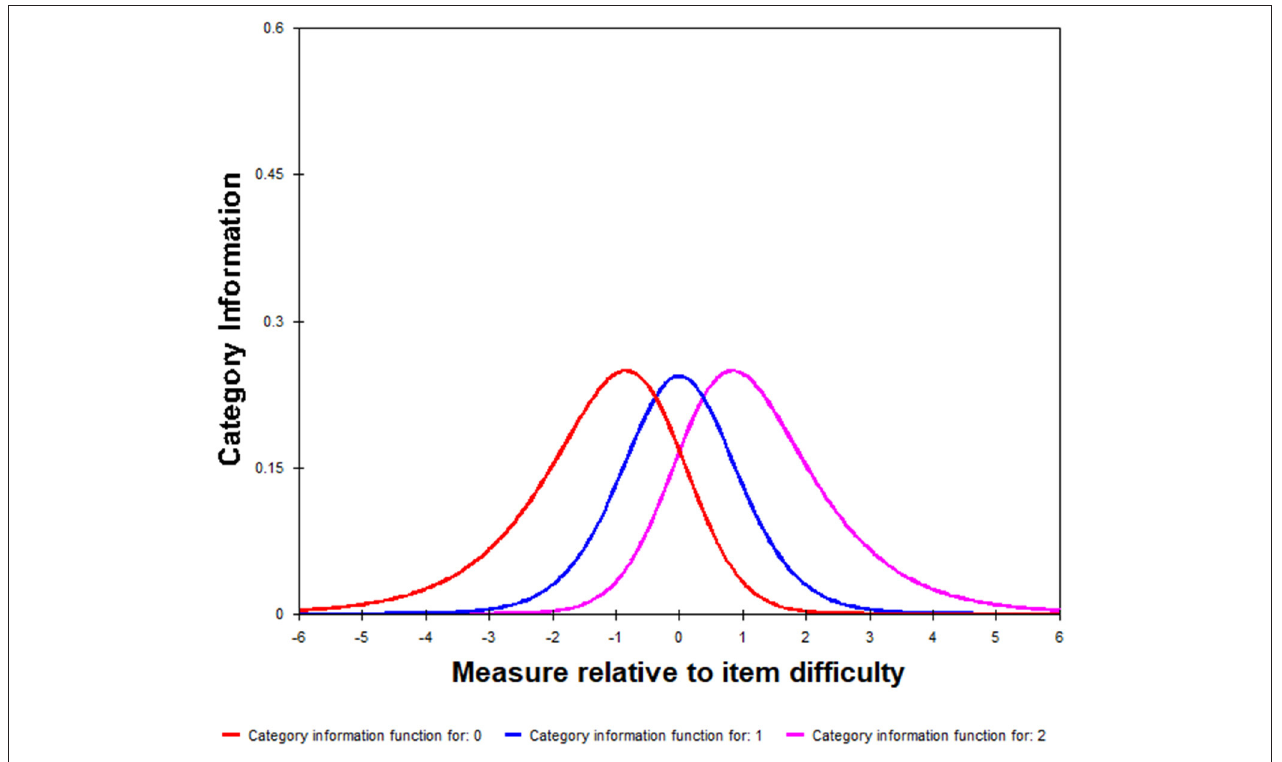
FIGURE 2 | Qualifier information for the